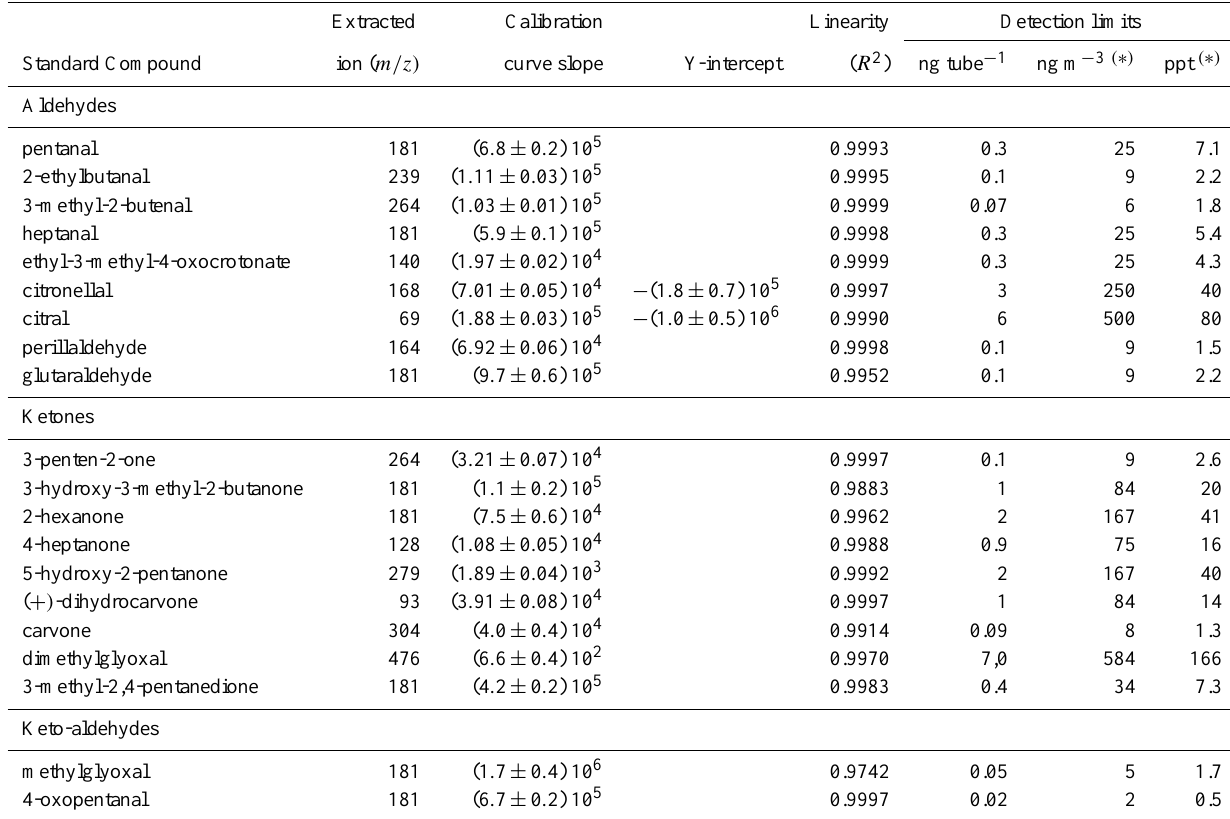
Table 1. Calibration curves slopes, linearities and detection limits for gaseous carbonyl compounds trapped on PFBHA-coated Tenax TA